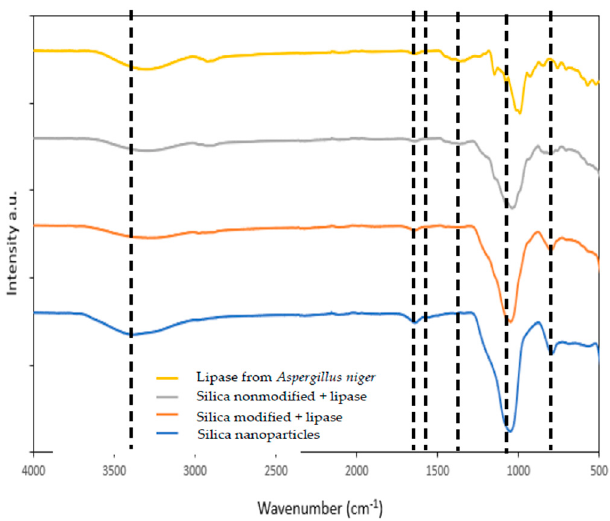
Figure 1. FTIR spectra of nanosilica (blue line), lipase from Aspergillus niger (yellow line), and nanosilica with immobilized lipase by physical immobilization by the adsorption interactions and partially interfacial activation and mixed physical immobilization via interfacial activation and ion exchange.